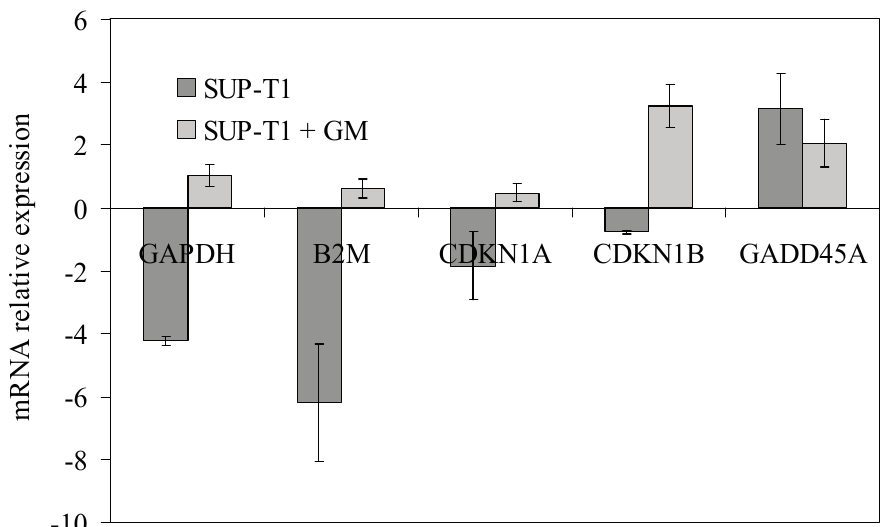
Figure 4. Effect of gentamicin on CDKN1A, CDKN1B, B2M, GAPDH and